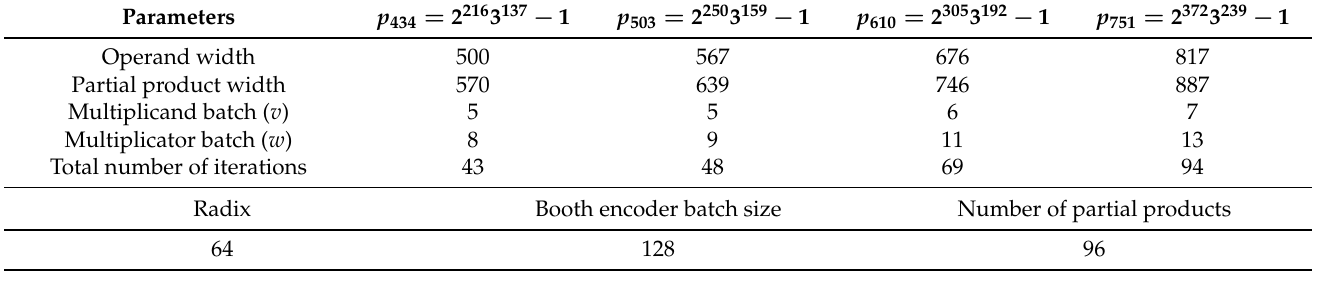
Table 2. Quadratic multiplier unit parameters determination.